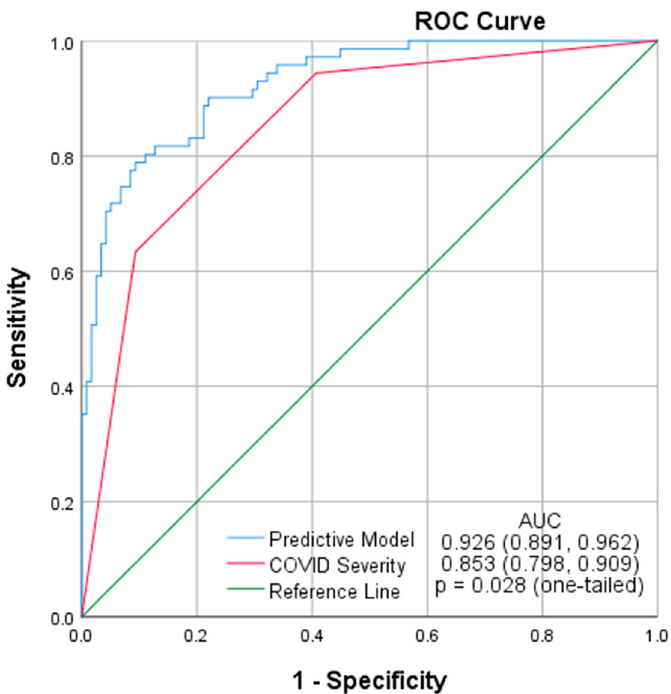
Figure 8. Comparing the AUROC of the predictive model with that of COVID severity in predicting mortality of COVID-19 patients in the validation dataset ( N = 189).